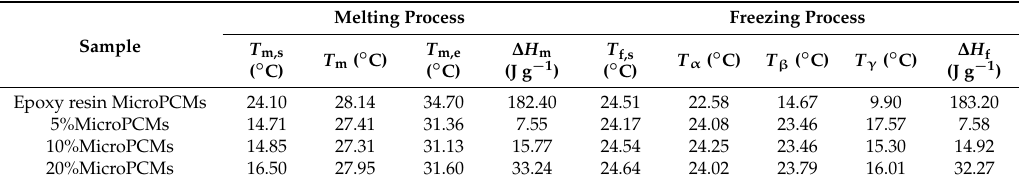
Figure 8. DSC curves of pure epoxy resin and MicroPCMs/epoxy composites with different MicroPCM contents.